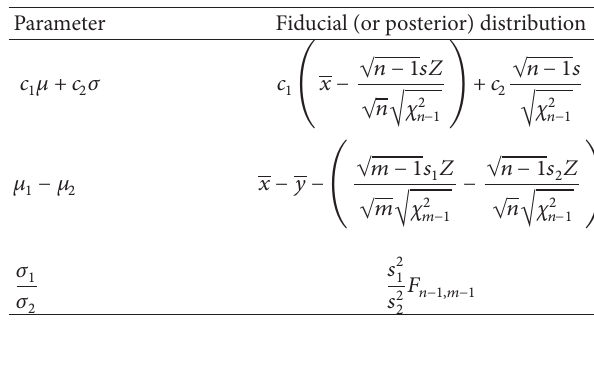
Table1:Fiducial(orposterior)distributionsforsomeimportantpa- rameters of interest under the normal